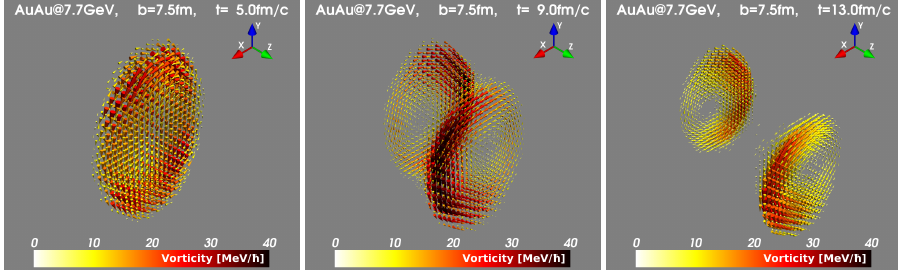
√ s NN = 7.7GeV with